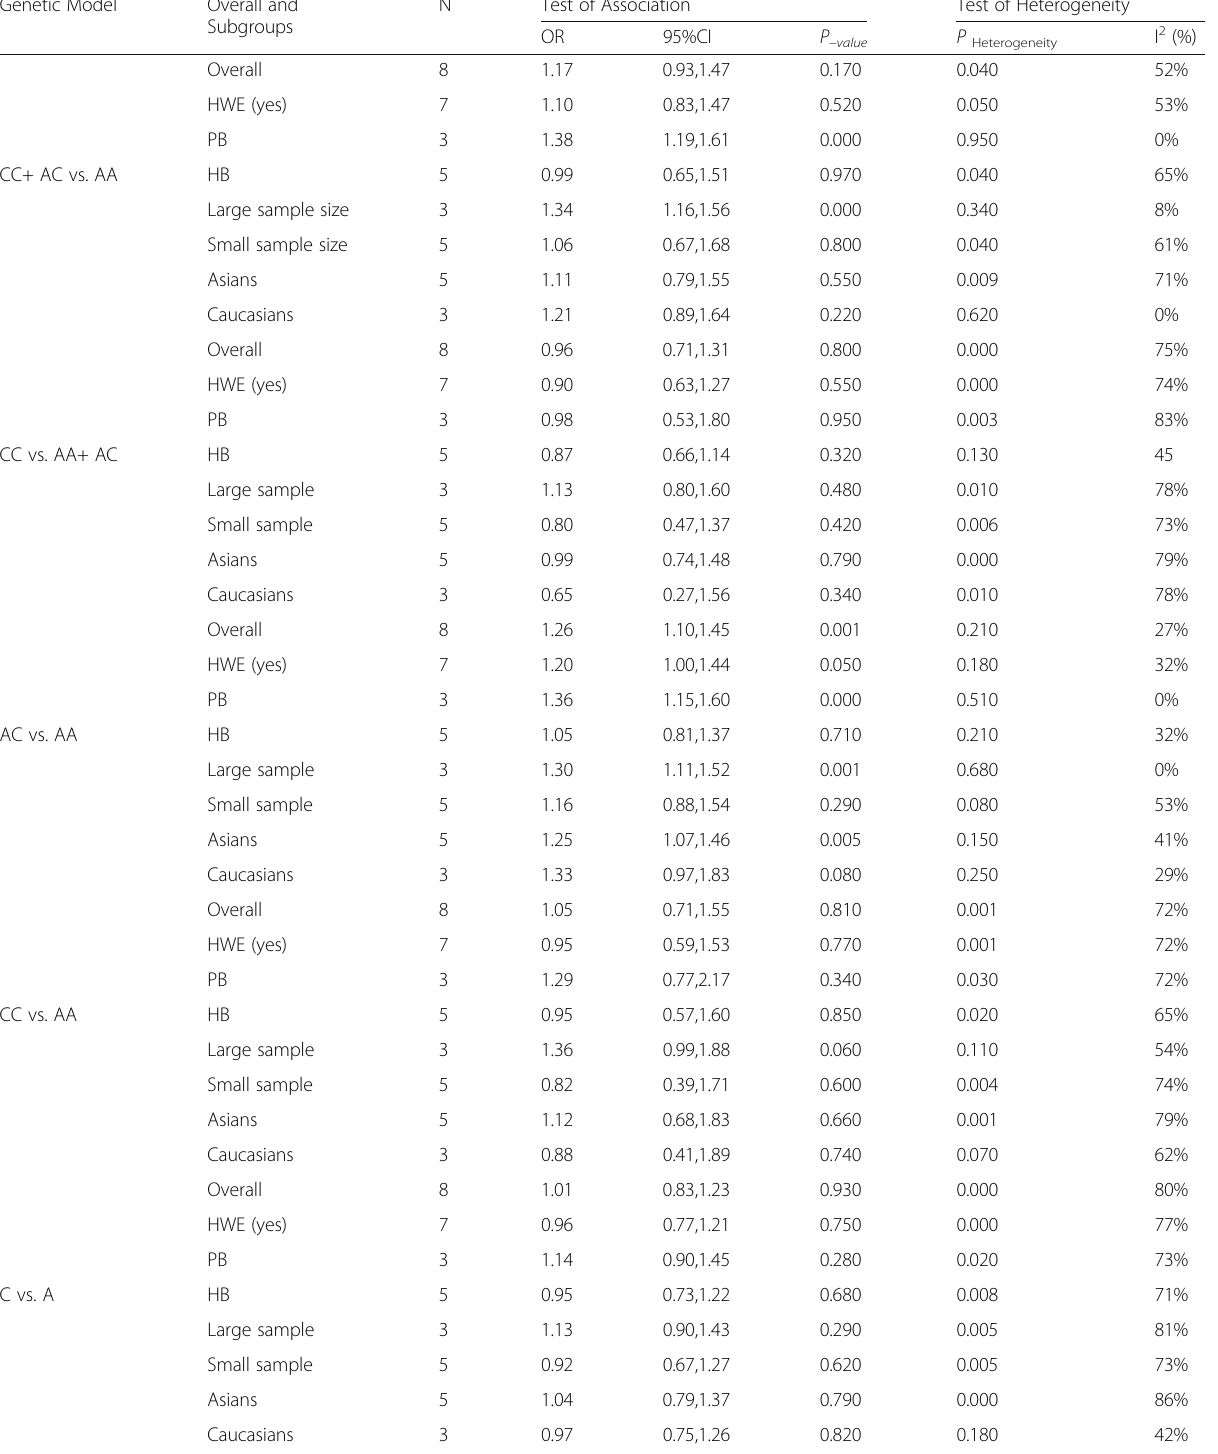
Table 2 Summary of odds ratios (95% CI) in the analysis of the relationship between VEGF gene polymorphisms in rs699947 and coronary artery disease susceptibility Genetic